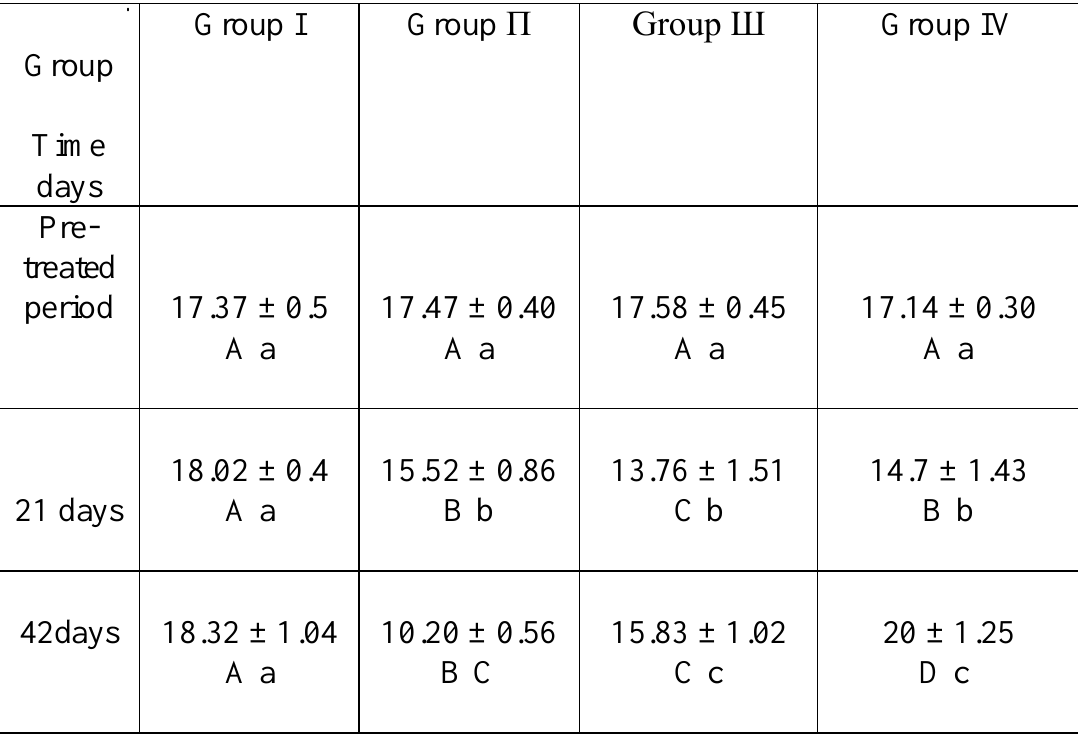
Table (1): Effect of black currant concentrate (Vitis vinfera.L) and vitamin E on prothrombin time (second) in H2O2 treated